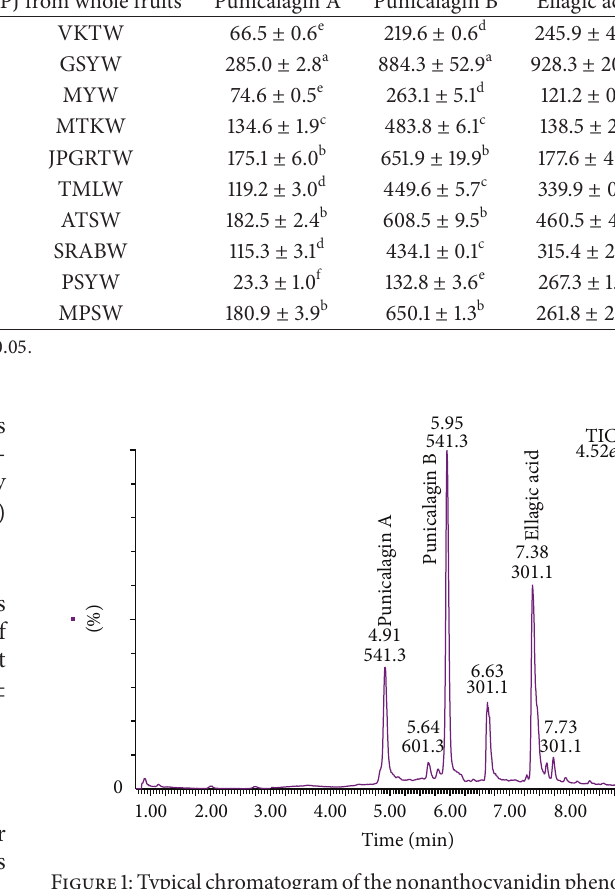
Table 1: Contents of individual phenolic compounds (mg/L) in pomegranate juices (PJ). PJ from arils Punicalagin A